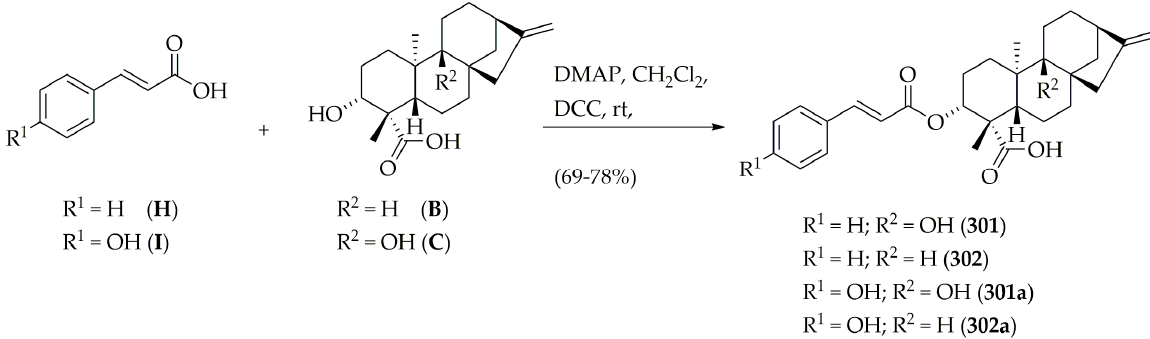
Figure 4. Synthetic route to produce phenylpropanoid/diterpene ester adducts 301 , 302 , 301a , and 302a .